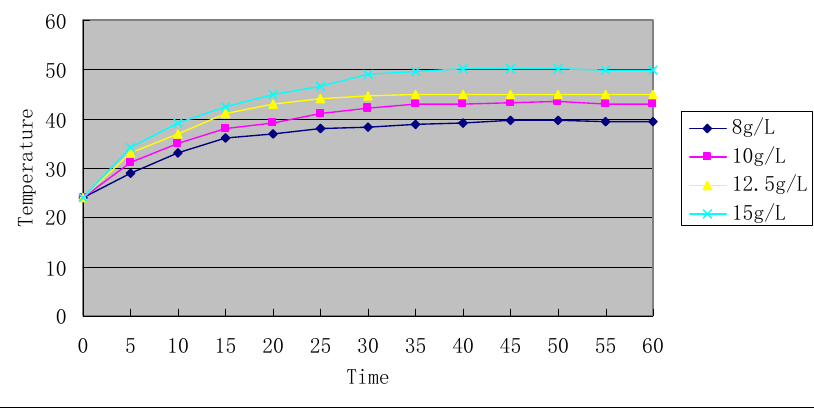
Figure 2. Heating test curve of sized Mn